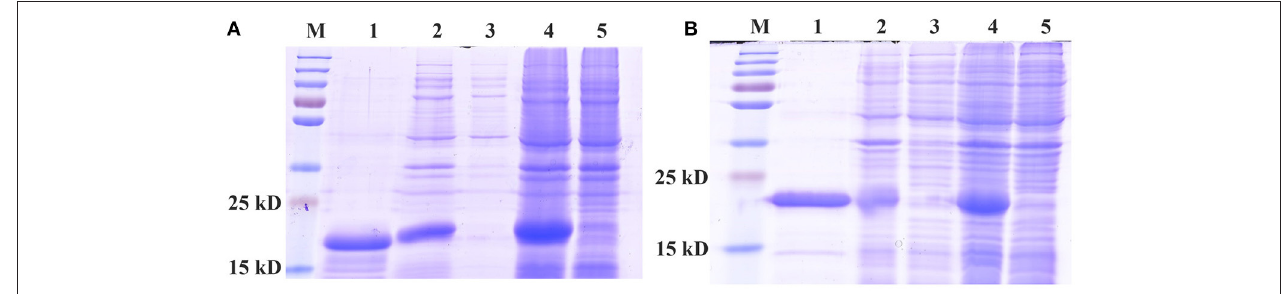
FIGURE 1 | SDS-PAGE analyses of expressed recombinant of CpunPBP2 (A) and CpunPBP5 (B) . M, marker protein; 1, purified fusion protein; 2, inclusion body of induced cells; 3, supernatant from ultrasound treated cells; 4, IPTG induced E. coli pET30a ( + )/CpunPBPs transformed BL 21(DE3) cells; 5, Non-induced pET30a ( + )/CpunPBPs transformed BL 21(DE3) cells.